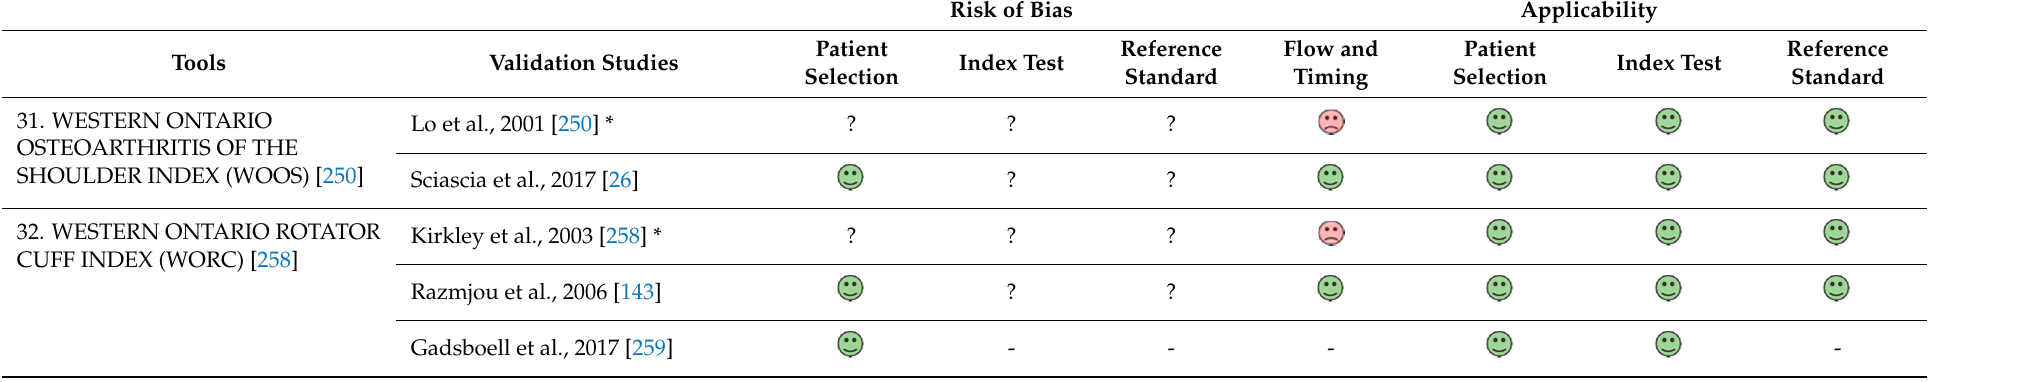
Table 3. Assessment of the methodological quality with QUADAS ‐ 2.